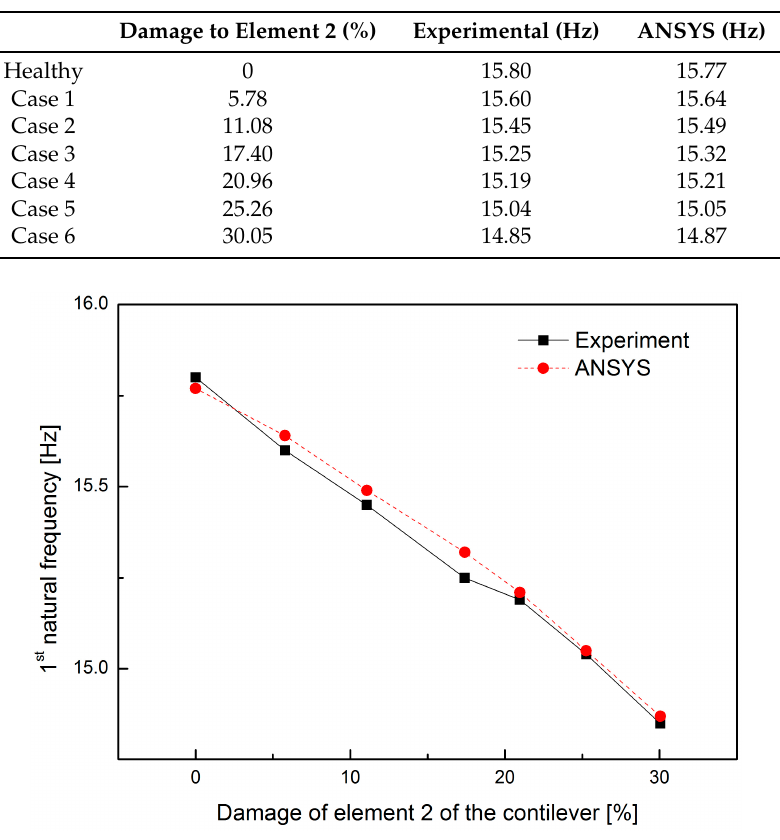
Figure 10. First natural frequencies for various damage cases.